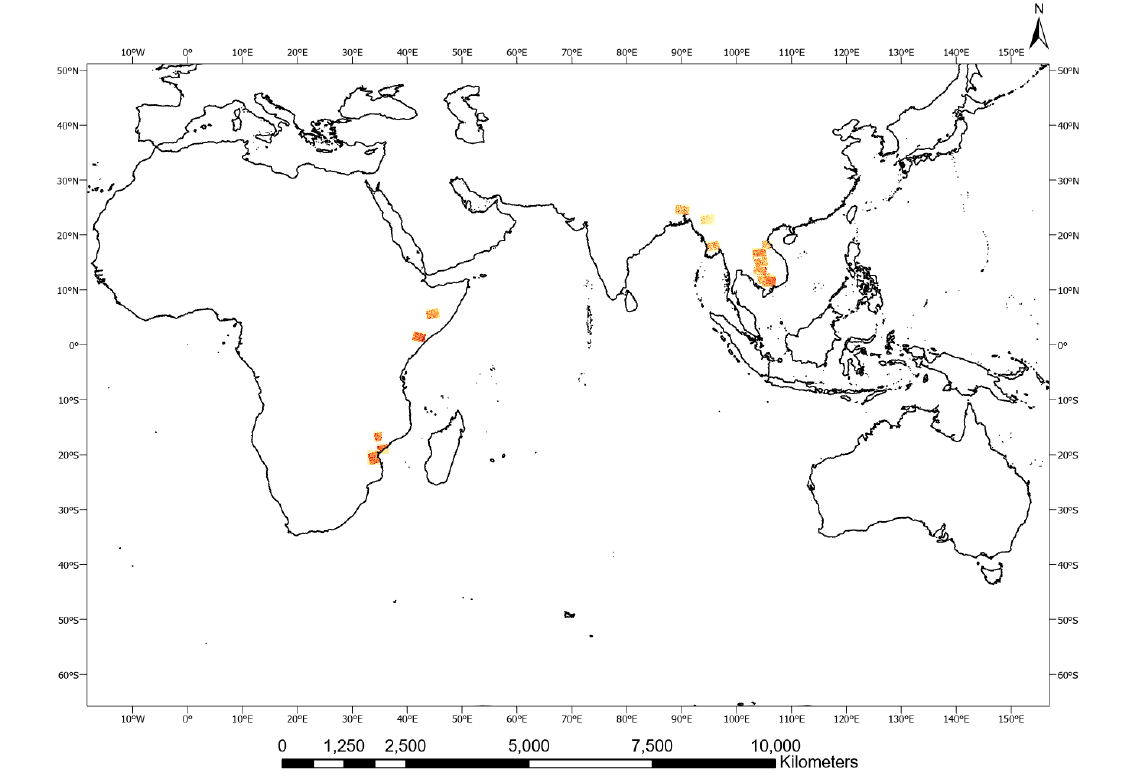
Figure 2. Locations included in the UNOSAT Flood